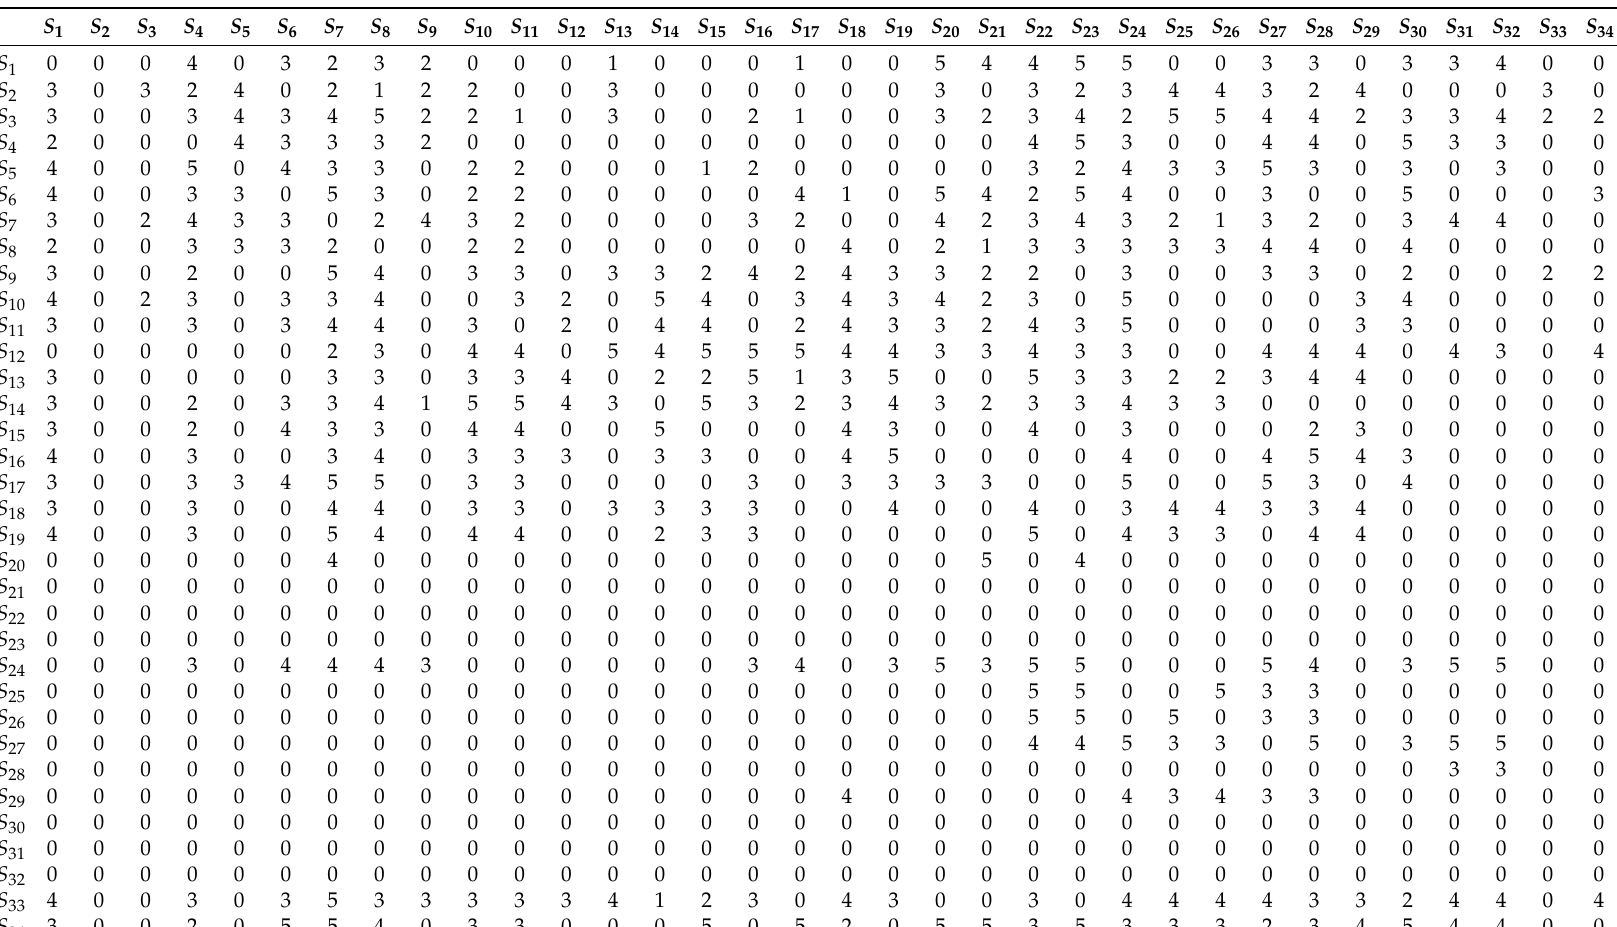
Table 2. The direct relation matrix of